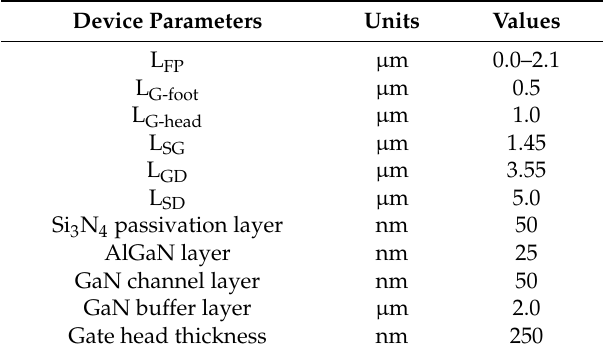
Figure 1. T-shaped gate AlGaN/GaN high electron mobility transistor (HEMT) structure: ( a ) fabricated two-finger device; ( b ) simulated T-shaped unit structure. The S, D, and G stands for source, drain, and gate, respectively. Table 1. Device geometrical parameters.